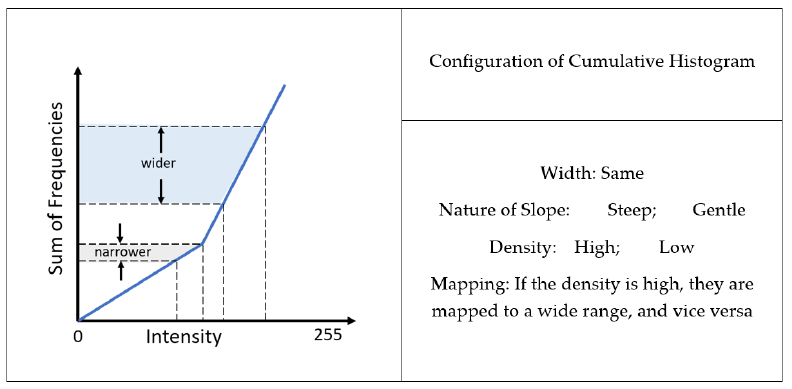
Figure A1. Concept of Cumulative Histogram.